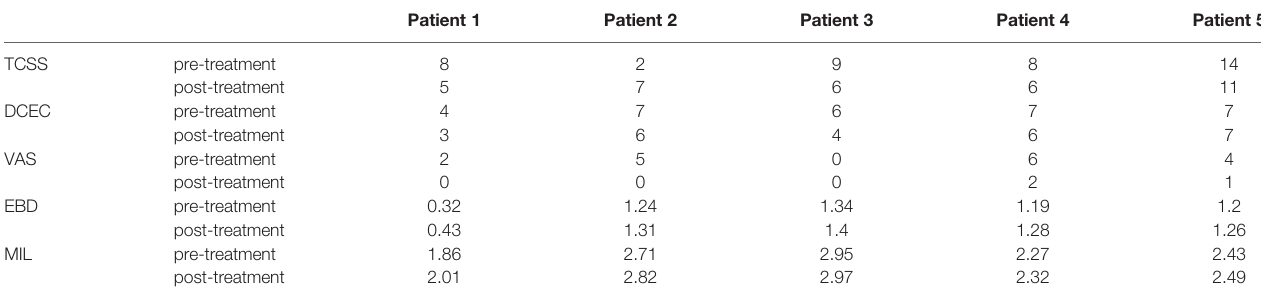
TABLE 3 | Evaluation of symptoms, ultrasound and cross-sectional area in